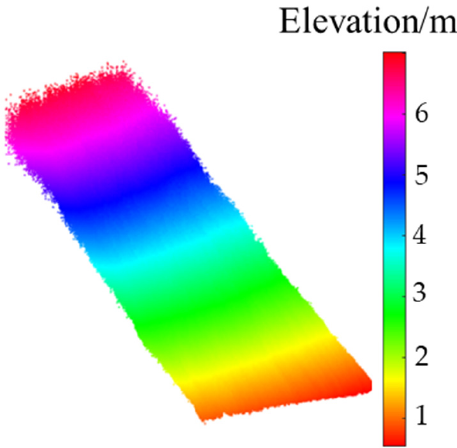
Figure 26. Point cloud of Lihua landslide.